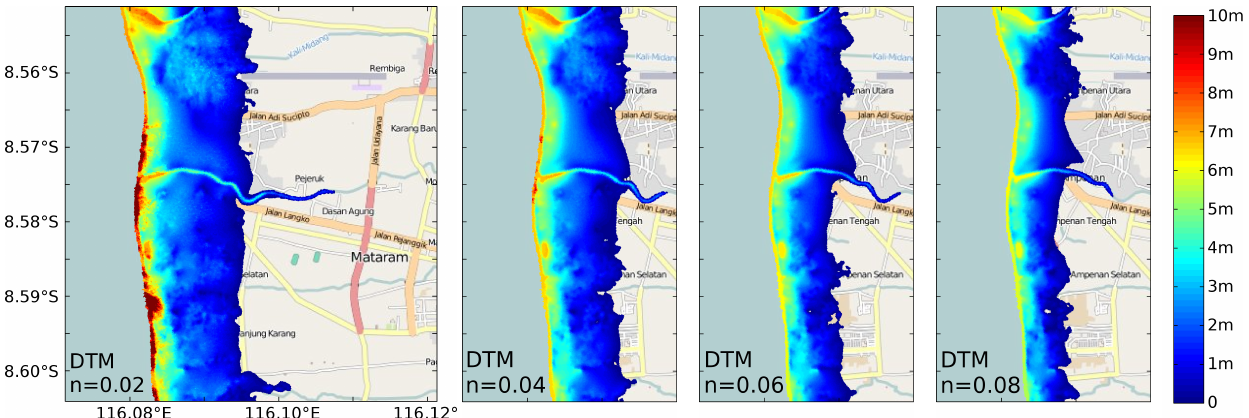
Fig. 16. Flowdepth in the model study for Mataram/Lombok (background © OpenStreetMap contributors) based on Intermap DTM with four different Manning parameters n = 0 . 02 , 0 . 04 , 0 . 06 , 0 . 08 from the left to the right panel.